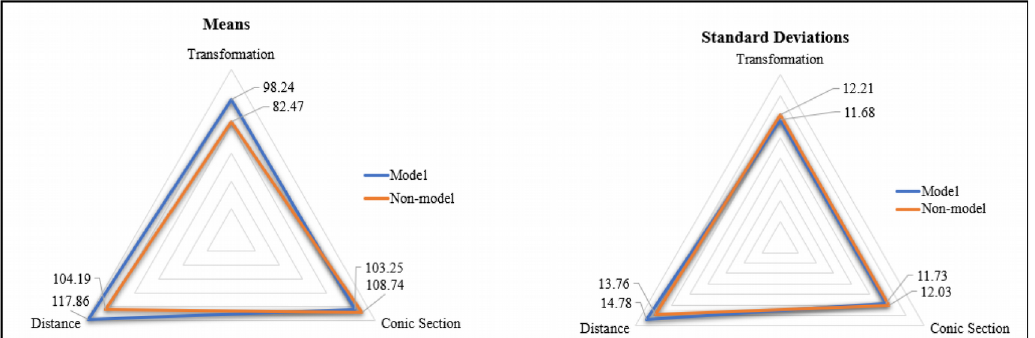
Figure 4. Means and standard deviations of the GAI test